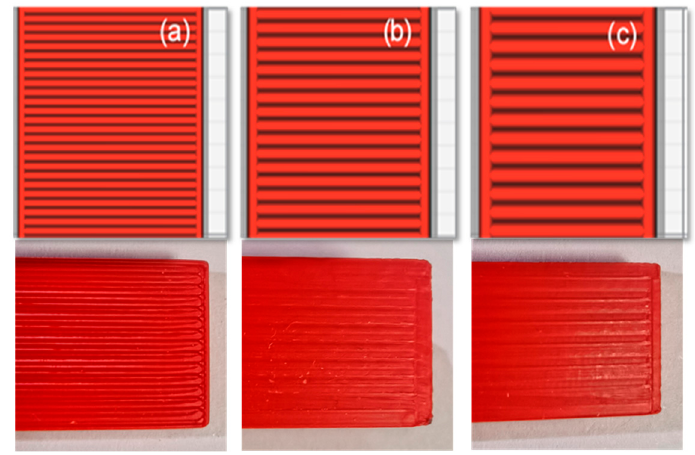
Figure 3. Three different nozzle sizes: ( a ) 0.4 mm; ( b ) 0.6 mm; ( c ) 0.8 mm [33].